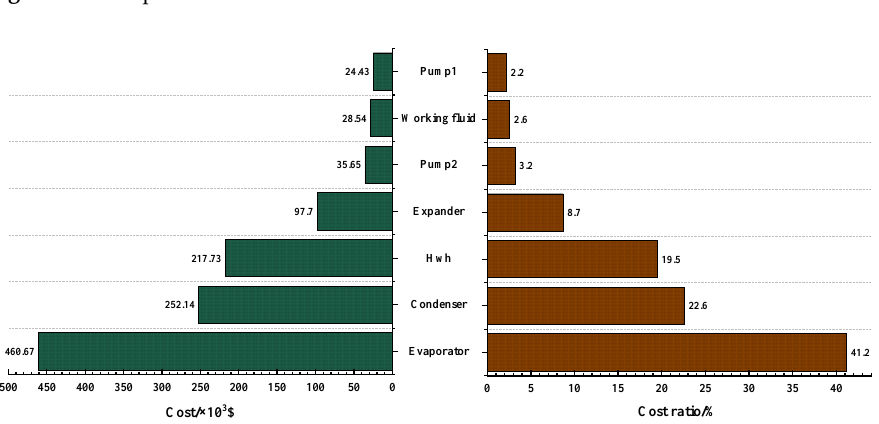
Figure 15. Component costs of CS.